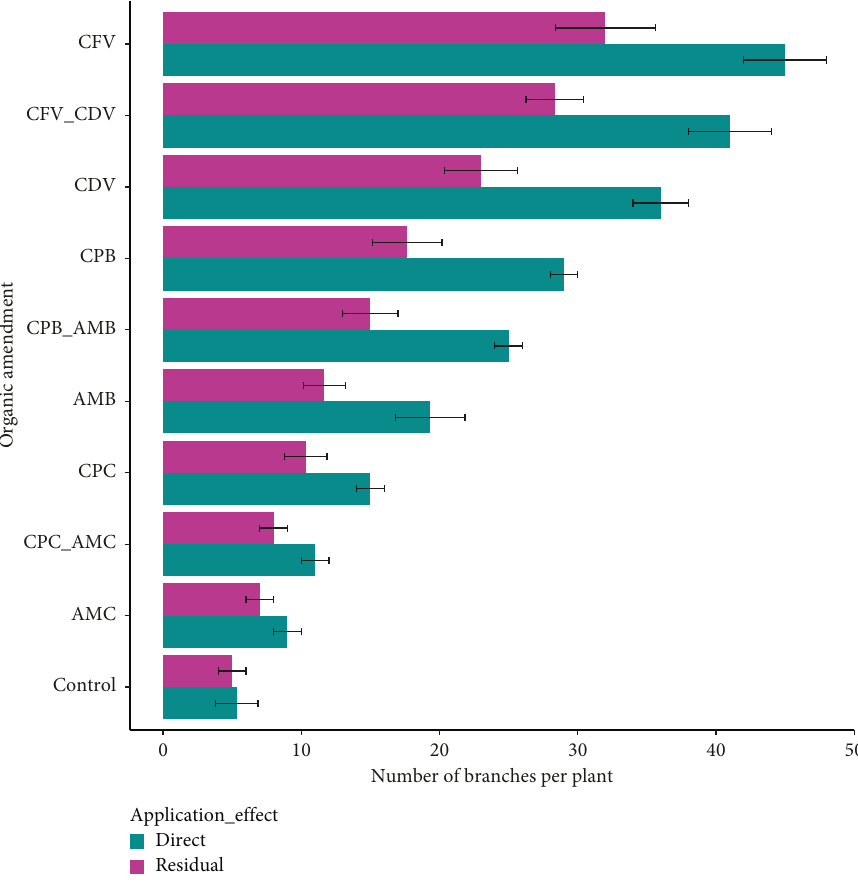
Figure 5: Number of branches per plant in different organic